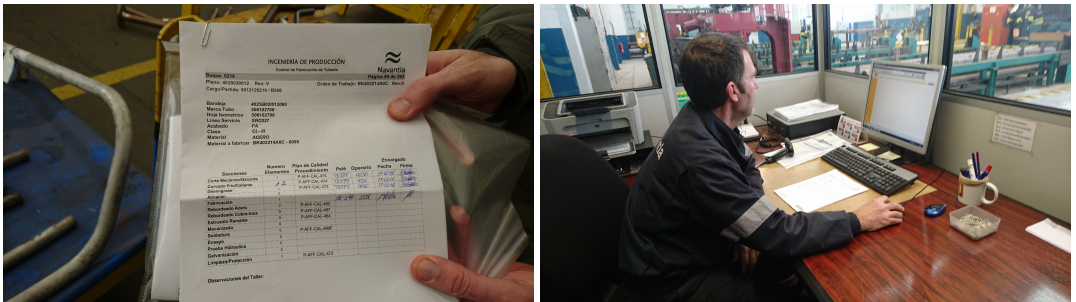
Figure 5. Traditional paper-based pipe process and quality